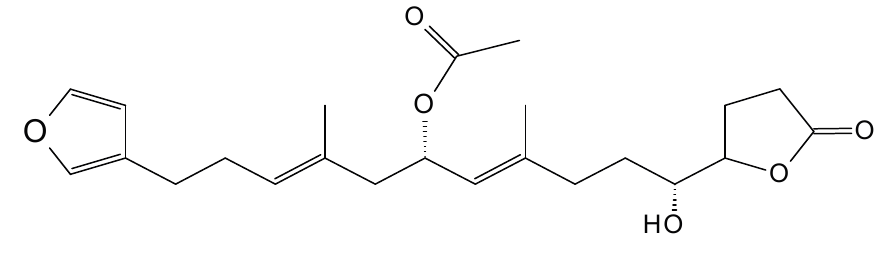
Figure 39. 10-Acetylirciformonin B ( 115